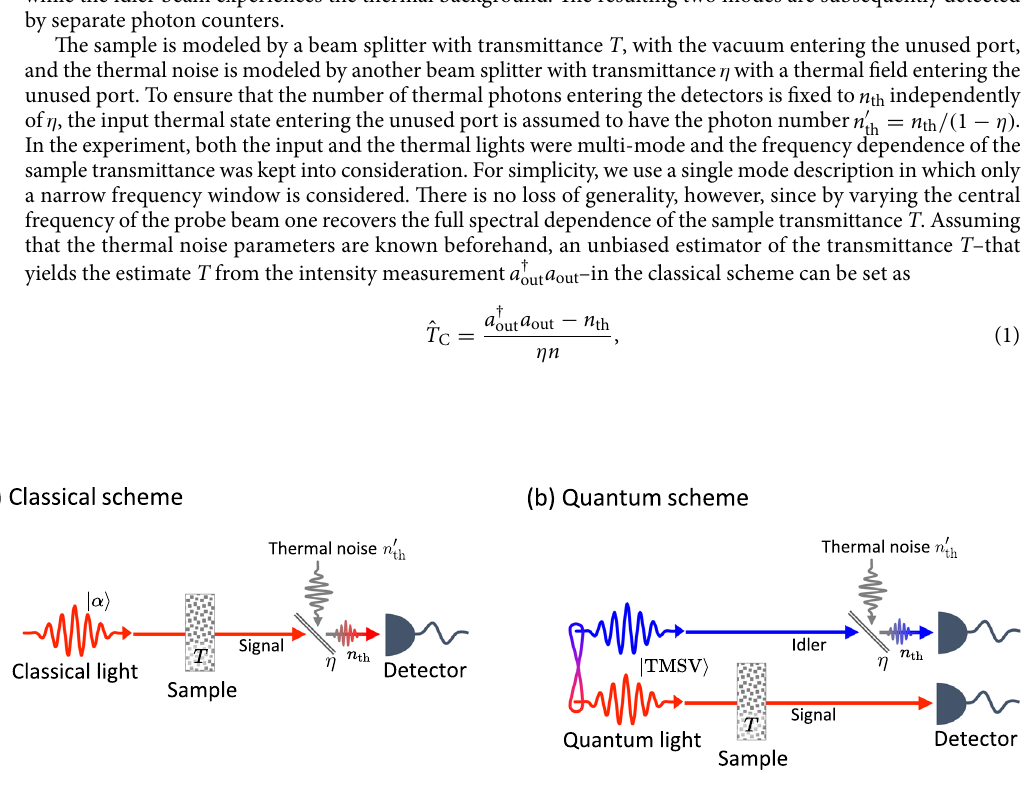
Figure 1. Diagrammatic illustrations of the classical and quantum setups investigated in Ref. 1 . ( a ) In the which a thermal noise n ′ th is injected from the background. ( b ) In the quantum scheme, the signal mode of a two-mode squeezed vacuum (TMSV) probe passes through the sample, while the idler mode experiences the thermal